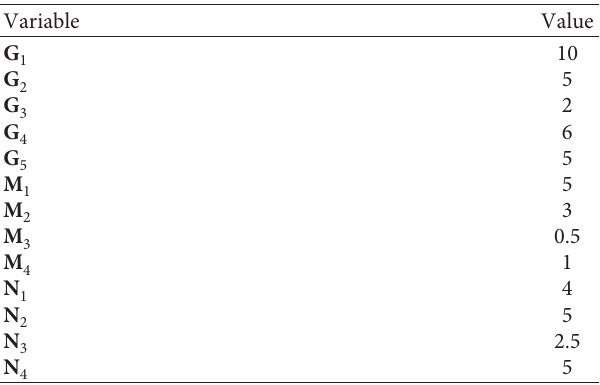
Table 4: Variable